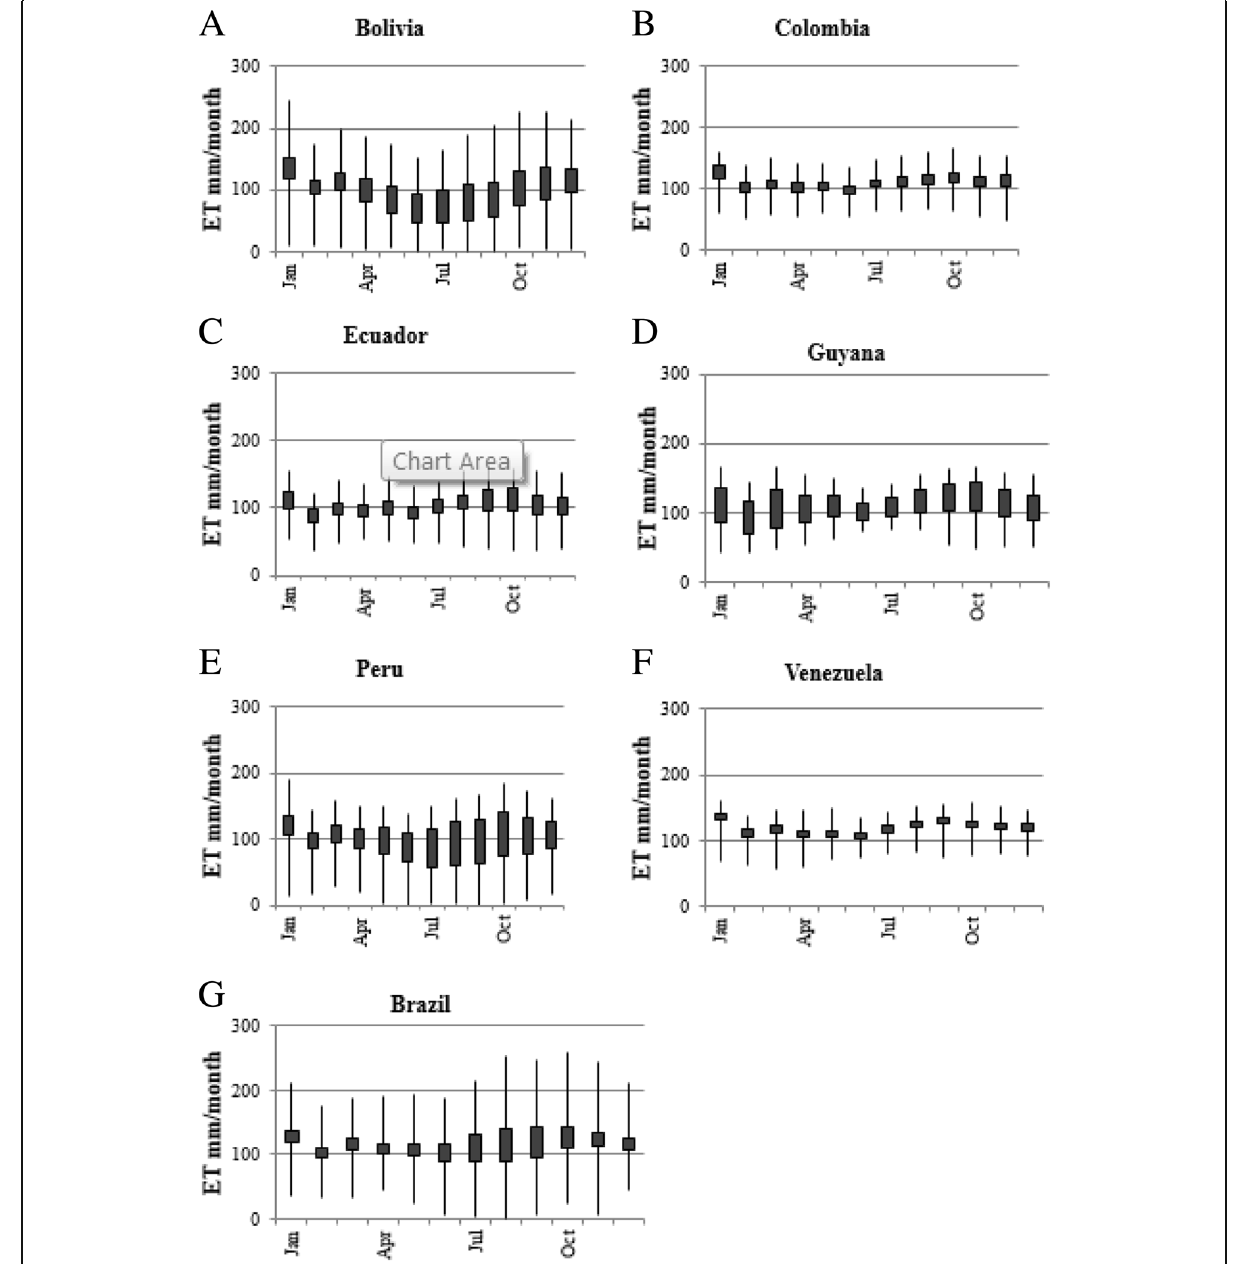
Fig. 8 Monthly ET rates for Bolivia ( a ), Colombia ( b ), Ecuador ( c ), Guyana ( d ), Peru ( e ), Venezuela ( f ), and Brazil ( g ). The mean values and the standard deviations are